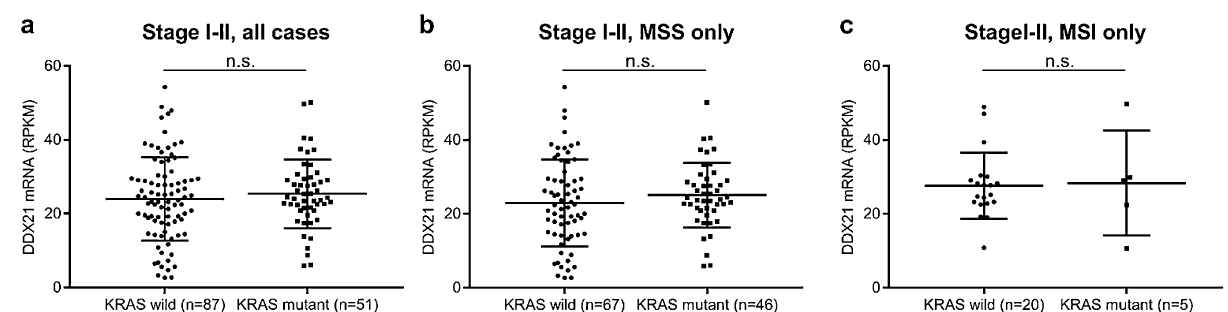
Figure 6. Comparison of DDX21 gene expression levels for early stage (stages I and II) CRC stratified by KRAS gene status (wild type vs. mutant) using the TCGA CRC cohort (n.s., difference not significant). ( a ) Comparison for all early stage cases. ( b ) Comparison for MSS cases only. ( c ) Comparison for MSI cases only. Horizontal lines show mean (long lines) ± 1 SD (short